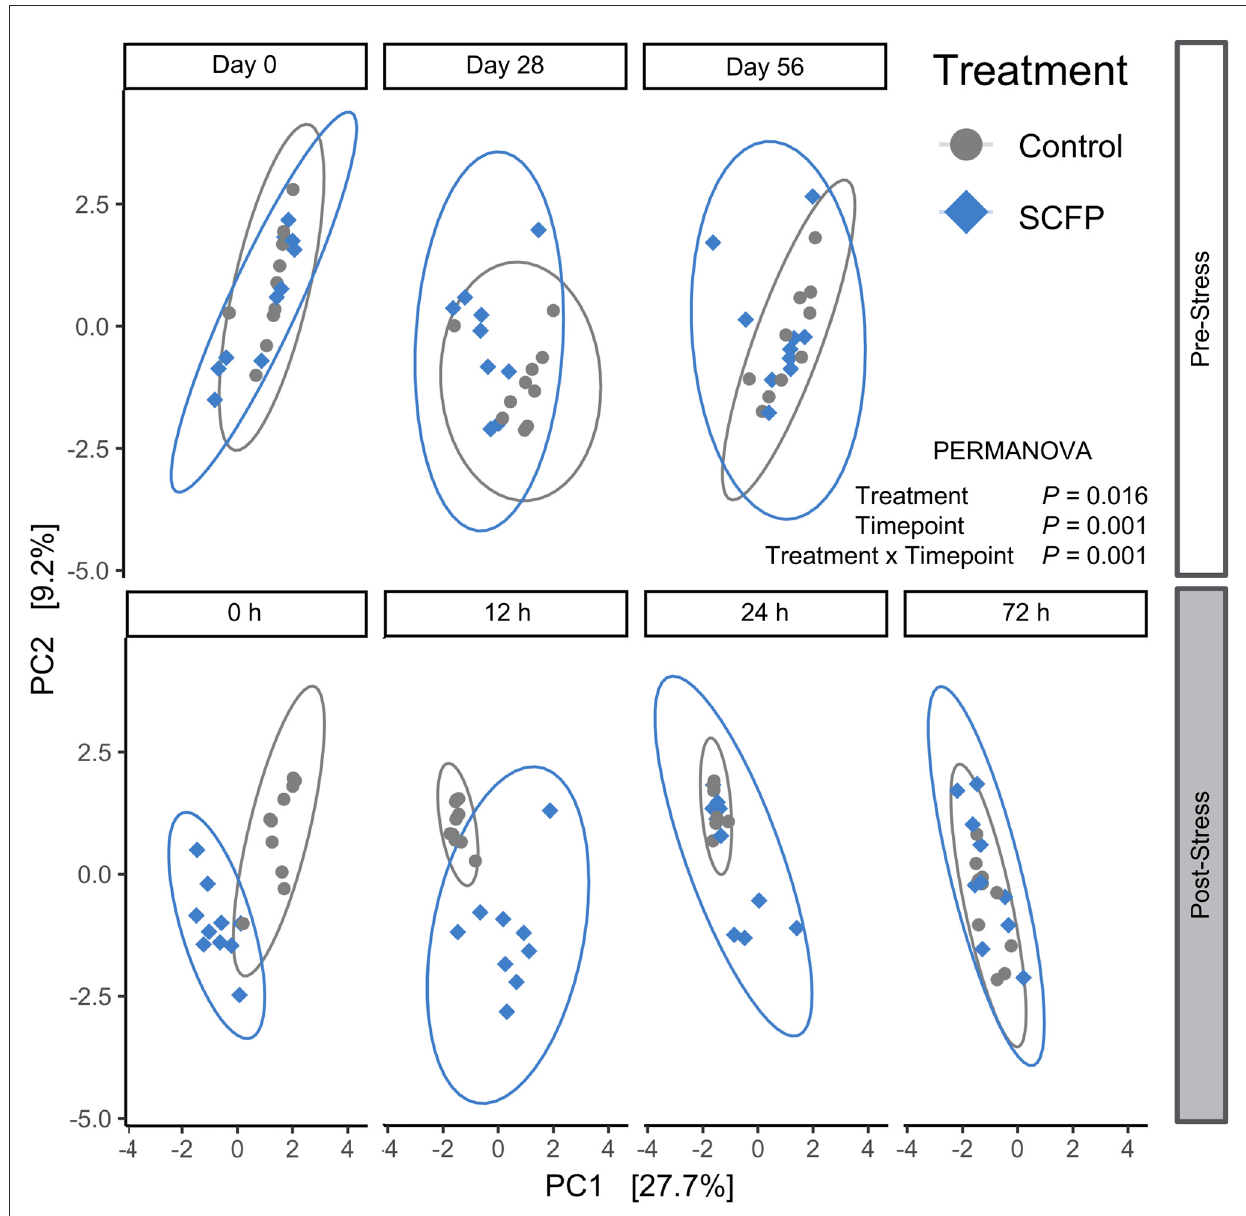
FIGURE3 Beta diversity comparisons. Aitchison distances were analyzed with permutational ANOVA (PERMANOVA) model which included treatment, timepoint, and their interactions. Plots depict principal component analysis of Aitchison distances with CLR transformed data.